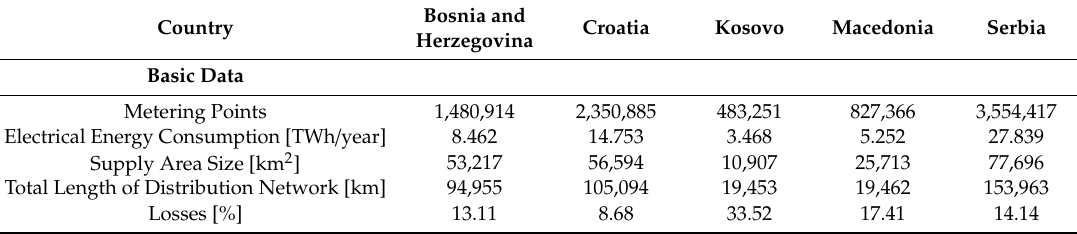
Table 1. Neighboring Grid Characteristics [34].